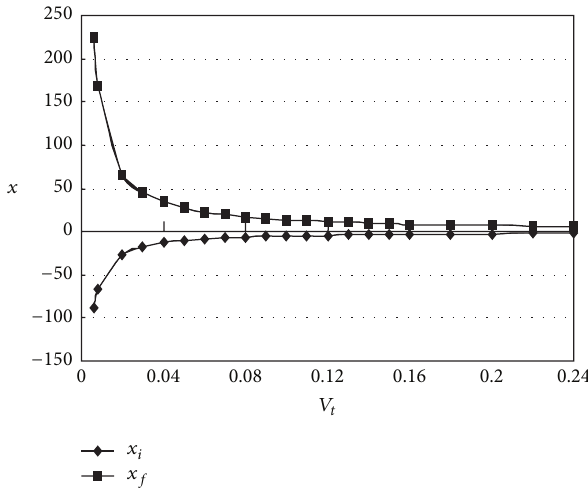
Figure 2: Limits of the mesh of particles inside the trapping region of the vortex as a function of 𝑉 𝑡 .